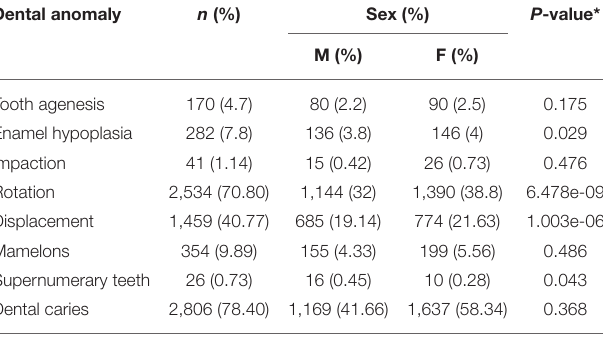
TABLE 2 | Distribution of dental anomalies by sex.